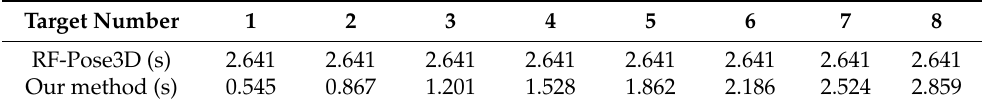
Table 3. Computation time